Question: Briefly state, in one sentence, what is plotted here.
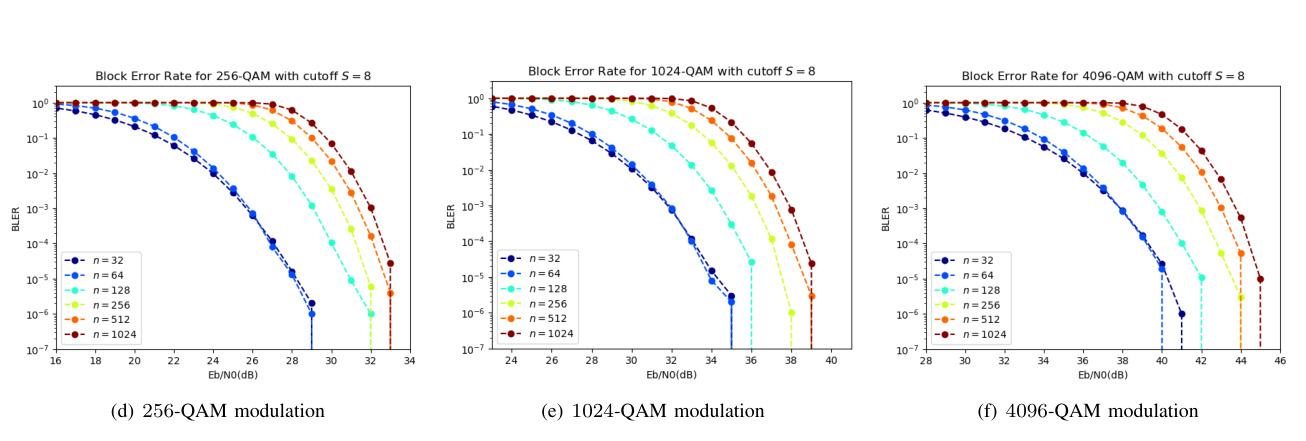
Answer: Simulation results: Block Error Rate (BLER) for the proposed GRAND-like approach for decoding Polar codes with codeword lengths N = 32, . . . , 1024 bits for different M-QAM modulations.